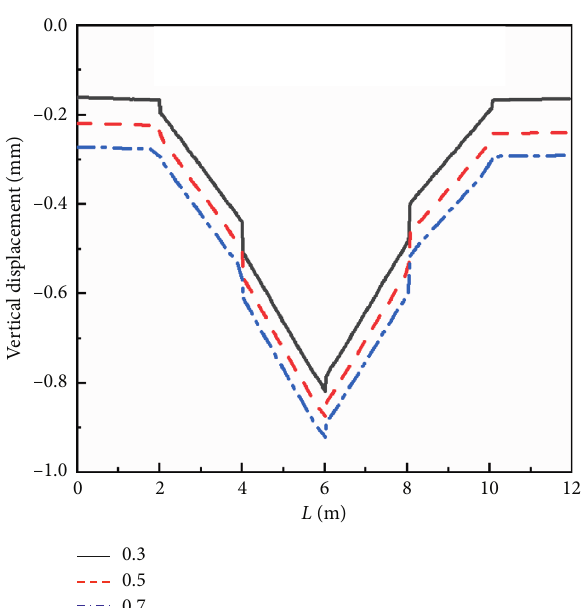
Figure 15: Longitudinal vertical displacement of the crown.